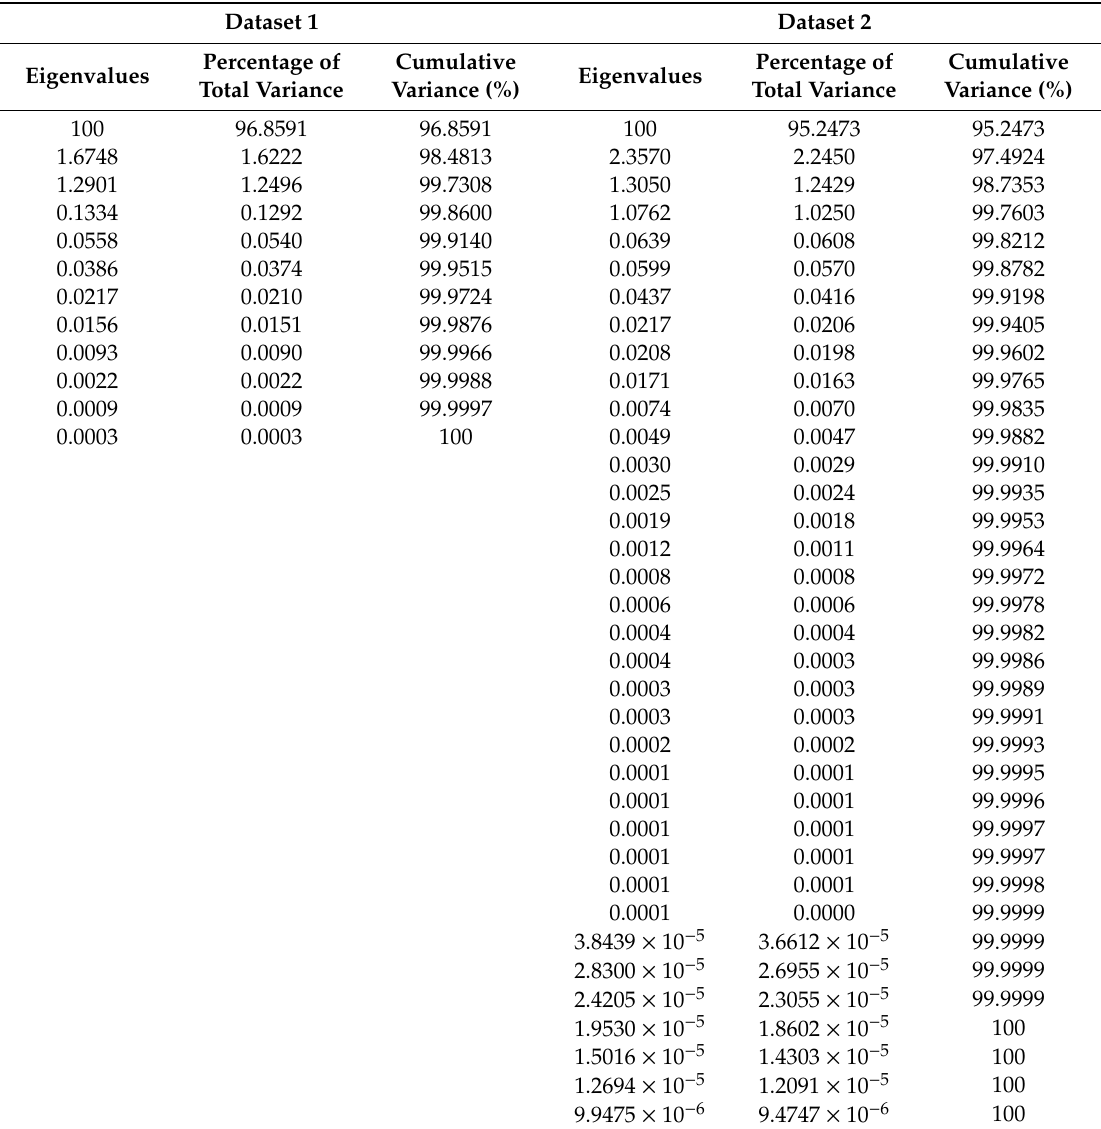
Table 4. Eigenvalues for both datasets of the unleaded gasoline